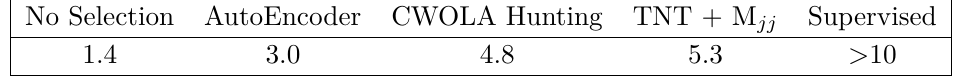
Table 2 . A comparison of the observed significance (in σ ’s) of a bump hunt search using various different classifiers to select events with a 3% efficiency. We also compare to the significance of a bump hunt on events prior to any classifier selection. Except for the supervised, the classifiers were trained on a sample with 0.3% of signal events. All significances are obtained on a validation sample that also has 0.3% signal events.